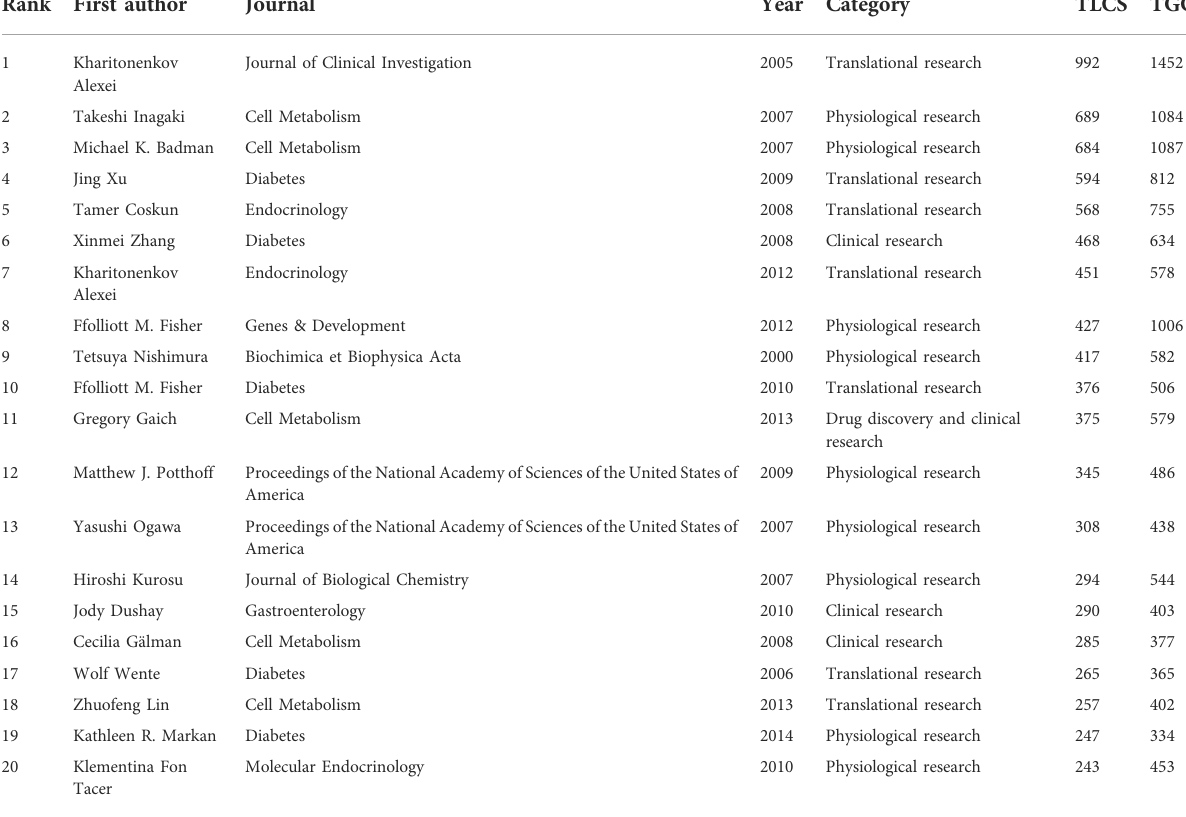
TABLE 5 Top ten publications with the highest